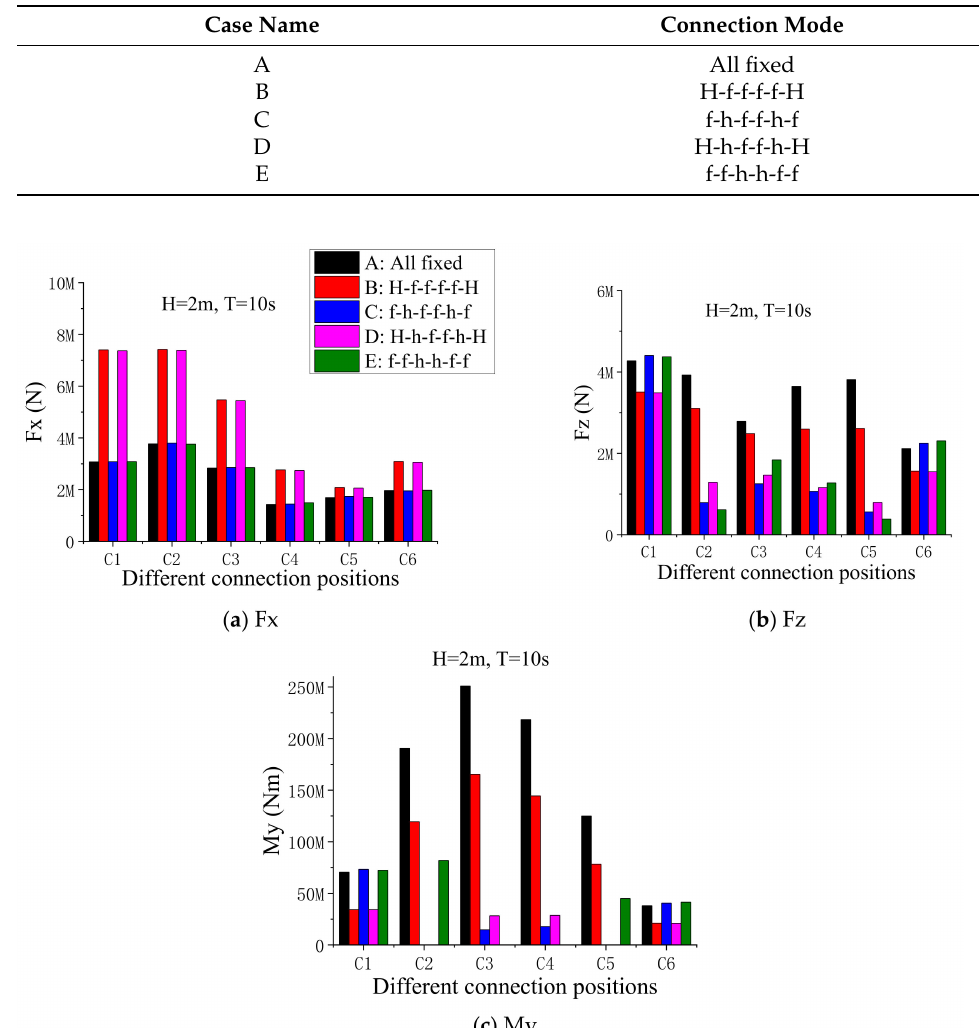
Table 2. Five connection modes for the MTLPW system.